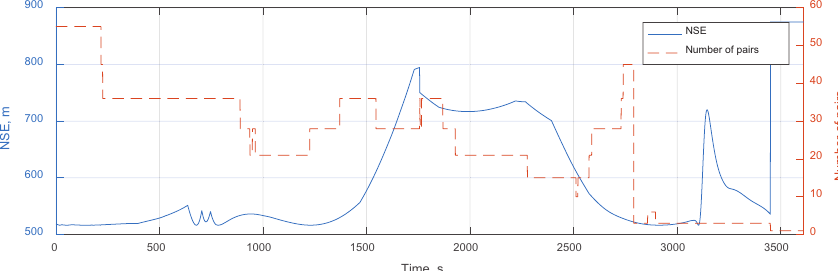
Figure 8. Navigation system error for optimal DME/DME pair and total number of